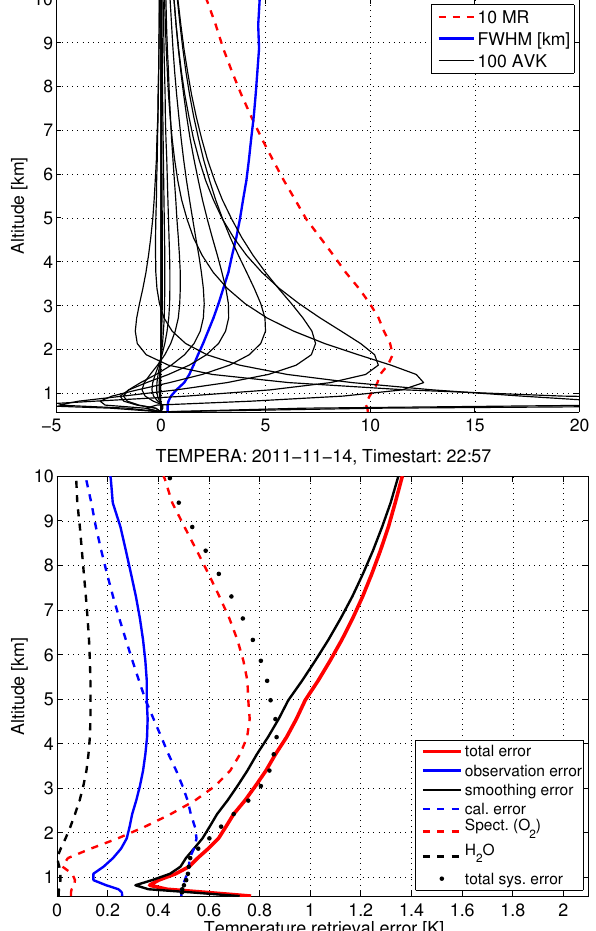
Fig. 10. Measurement of 14 November 2011 at 22:57–23:12 (UT) during cloudy sky (ILW=0.1mm). Upper panel: the averaging kernels (AVK, plotted every 4th) of TEMPERA are shown in this plot together with the measurements response (MR) and the full-width at half-maximum (FWHM, in km). Lower panel: error of the retrieval. The error statistics contain the total error (solid red) consisting of observation error (solid blue) and smoothing error (solid black). The total systematic error (dotted black) contains the uncertainties in the calibration (dashed blue), in the oxygen profile (“spectroscopic error”, dashed red) and in the water vapor profile (dashed black).